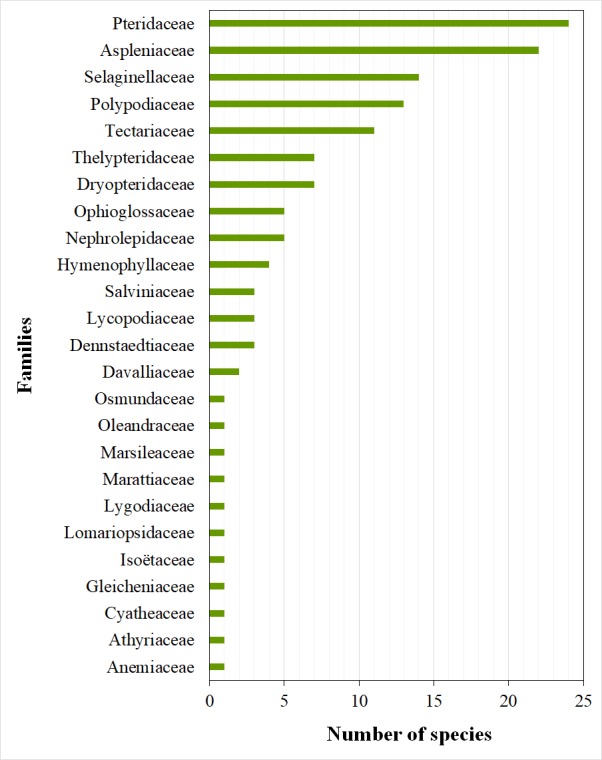
Species diversity of Pteridophytes families occurring in Togo